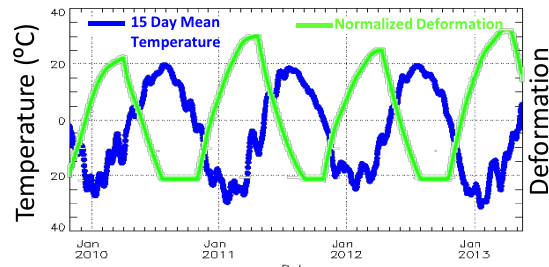
Figure 2. Example of a mean temperature history and derived active layer deformation